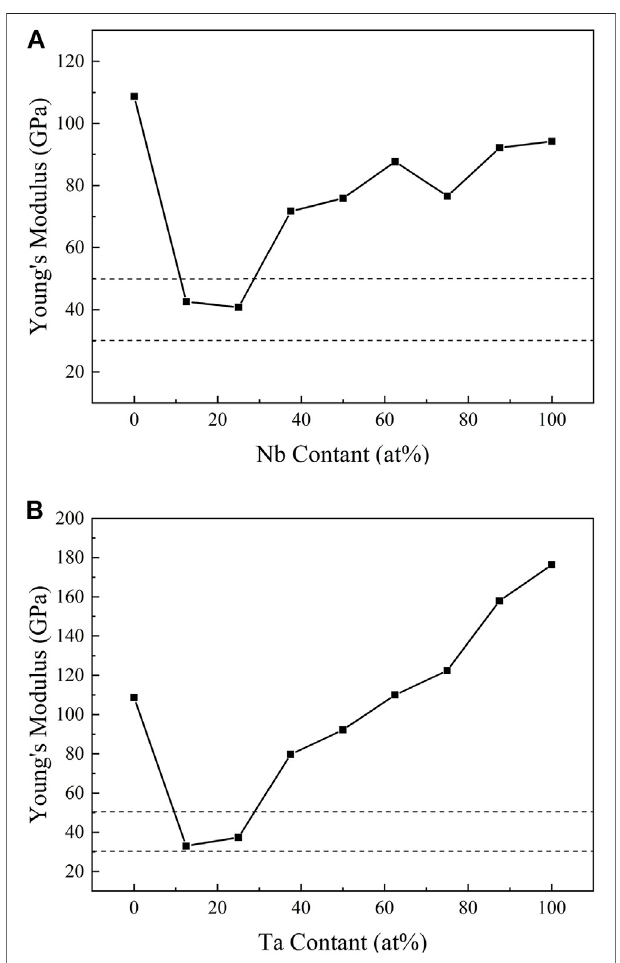
FIGURE 7 | Young ’ s moduli of (A) β -TiNb and (B) β -TiTa alloys.